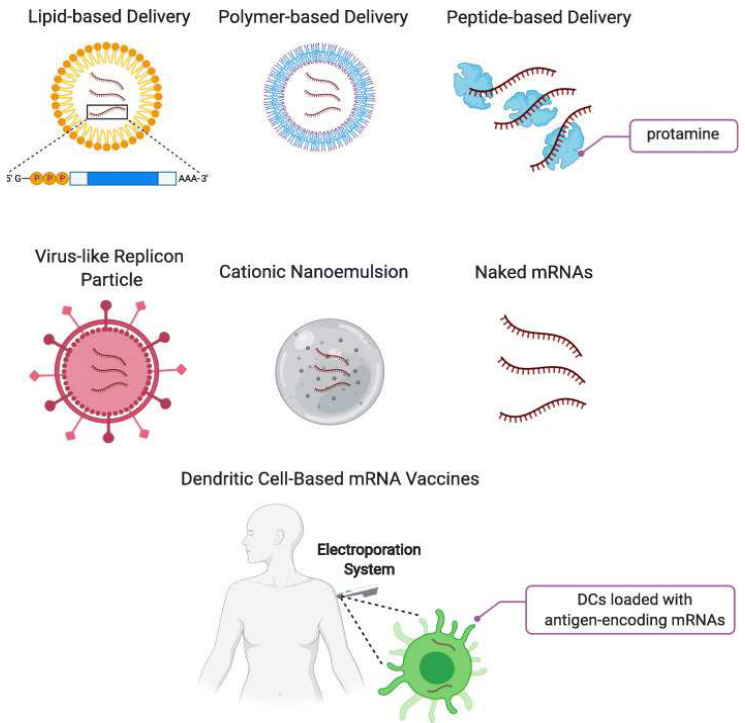
Figure 2. Summary of delivery methods for mRNA vaccines. Reprinted with permission from [55] .